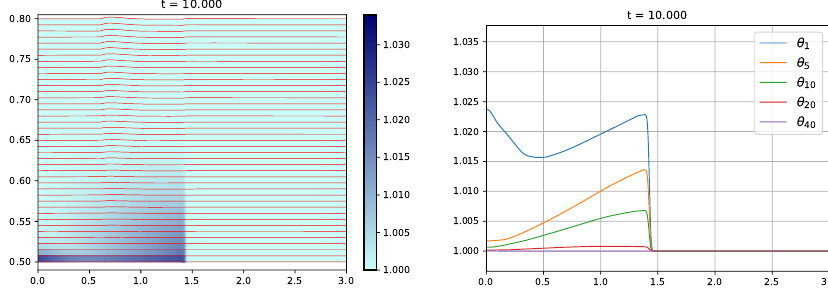
Figure 24. Evolution of the density driven current at t = 10 s.